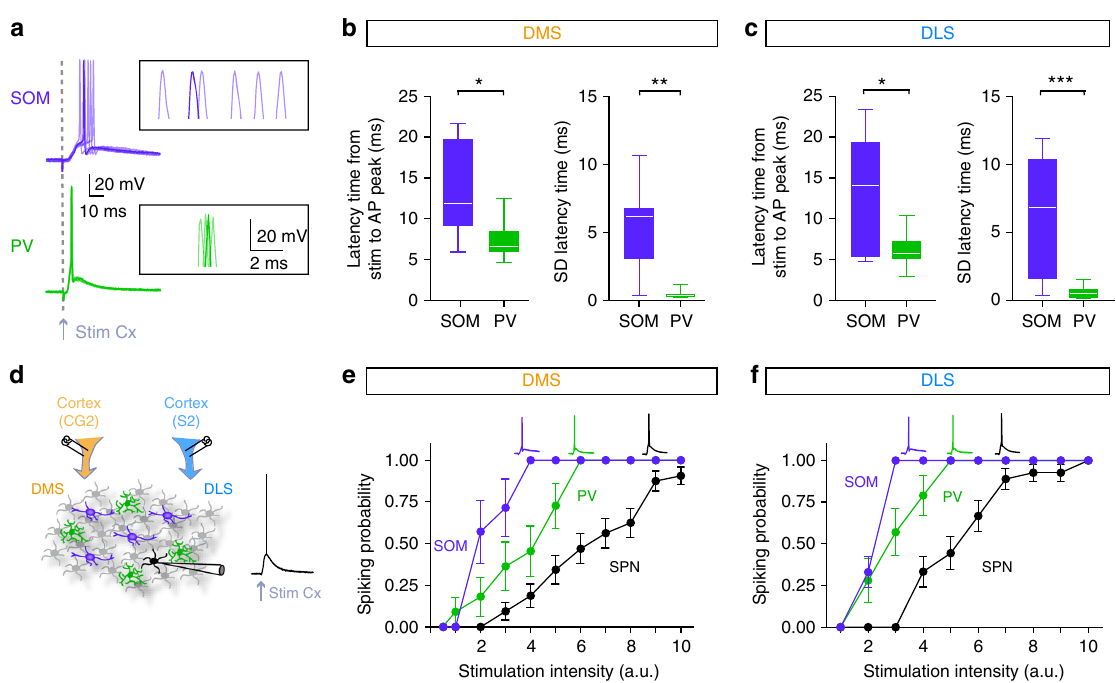
Fig. 2 SOM and PV cells are differentially recruited by cortical inputs in DMS and DLS. a Six superimposed APs evoked in either SOM or PV cells for a given cortical stimulation intensity. b , c Whisker boxes representing the latency, and the standard deviation (SD) of the latency, between the stimulation artifact and the peak of the AP in PV cells (green) and SOM cells (purple), in DMS and DLS. In both territories, PV interneurons display much shorter latency and SD than SOM cells, (DMS, p = 0.0148 for latency and p = 0.0019 for SD; DLS, p = 0.0334 for latency and p = 0.0004 for SD). PV cells display a short latency (6.38 ± 0.38 ms, n = 30) and a remarkable small SD of the latency (0.53 ± 0.07 ms, n = 30), and this with no signi fi cant difference between DMS and DLS ( p = 0.1127 for latency and p = 0.4641 for SD latency), accounting for a very time-locked PV cells recruitment. In contrast, APs evoked in SOM cells by cortical stimulation exhibited longer latency (13.31 ± 1.77 ms, n = 17) and a higher latency SD (5.75 ± 0.93 ms, n = 17), with no difference in DMS and DLS ( p = 0.8884 for latency and p = 0.7430 for SD latency, Mann – Whitney unpaired t -test). d Schematic representation of the experimental set up: electrical stimulations were applied in the cortex (CG2 for DMS slices and S2 for DLS slices) and evoked APs were recorded in SPNs, PV and SOM cells. e , f Input/output relationship (mean± SEM) is plotted for different neuronal subtypes, SPN (black), PV cells (green) and SOM cells (purple) in DMS ( e ) and DLS ( f ). Insets represent APs evoked in the different cell types after cortical stimulation. In both DLS and DMS, PV and SOM cells discharge for much lower cortical activation than SPNs ( F 2,20 = 20.19, p < 0.0001 for DMS, SPN n = 33, PV n = 11, SOM n = 8 and F 2,18 = 11.17, p = 0.0025 for DLS, SPN n = 27, PV n = 14, SOM n = 8, two-way ANOVA); * p < 0.05, ** p < 0.01, *** p < probability of SPN-DMS ( p = 0.005, n = 10), whereas the spiking